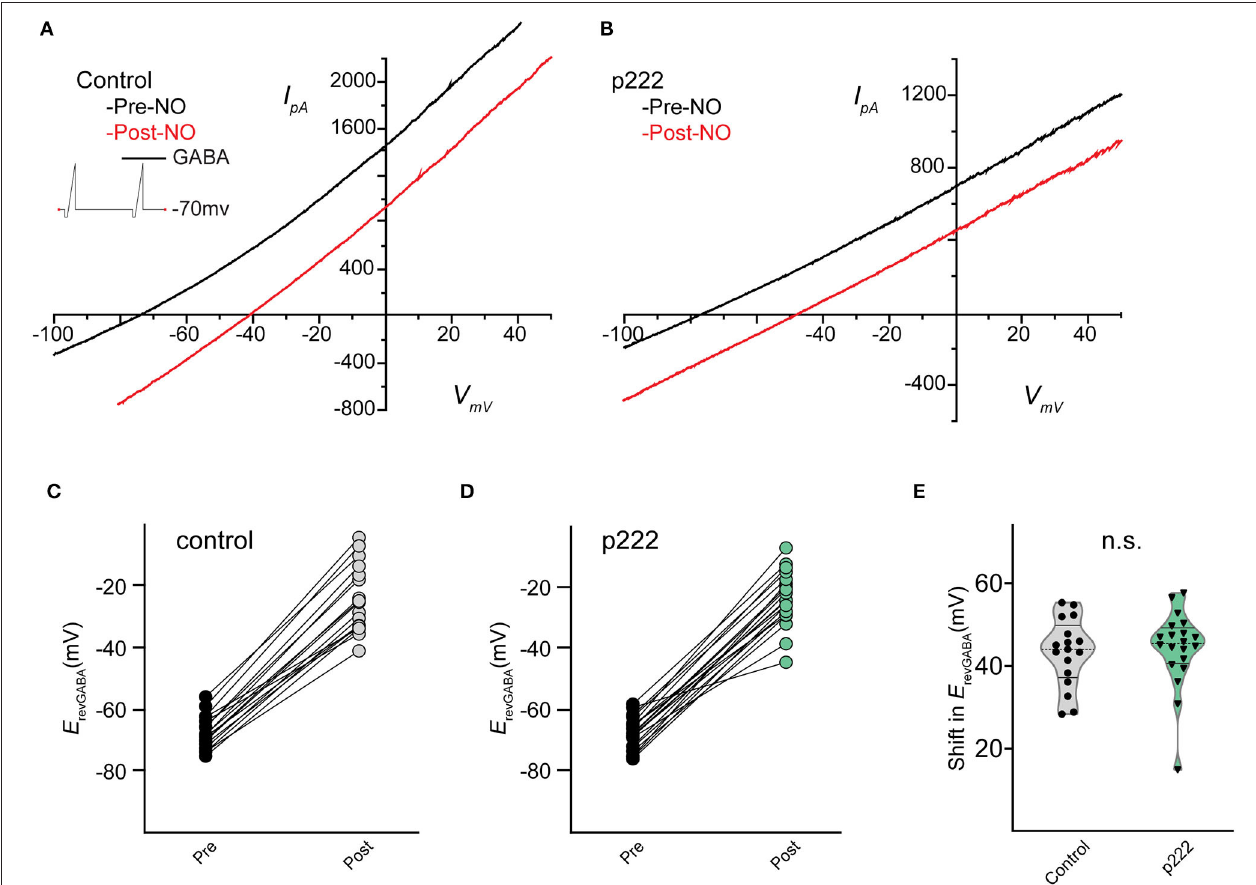
FIGURE 5 | Mean shift in the reversal potential of GABA A Rs for control and cells targeted with p222 do not significantly differ. Current–voltage relationship for leak subtracted GABA-gated currents in a representative control AC (A) and in a representative p222 transfected cell (B) . Paired data points for E revGABA before and after NO injection shift positively for all cells tested in control (C) and p222 transfected (D) groups. Violin plots of the mean shift in E revGABA (E) show no difference and similar frequency distribution between control and p222 transfected groups (control n = 17, p222 n = 20, p = 0.75 two-tailed Welch’s t-tests